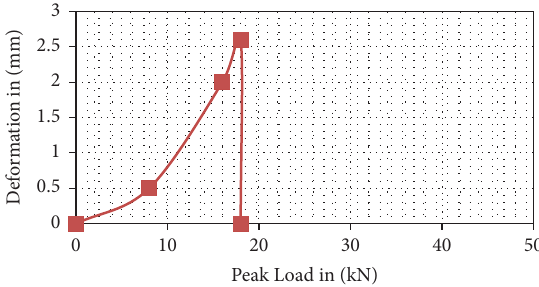
Figure 15: Fiber orientation of 0 ° /90 ° composite peak load (kN) Vs. deformation (mm).